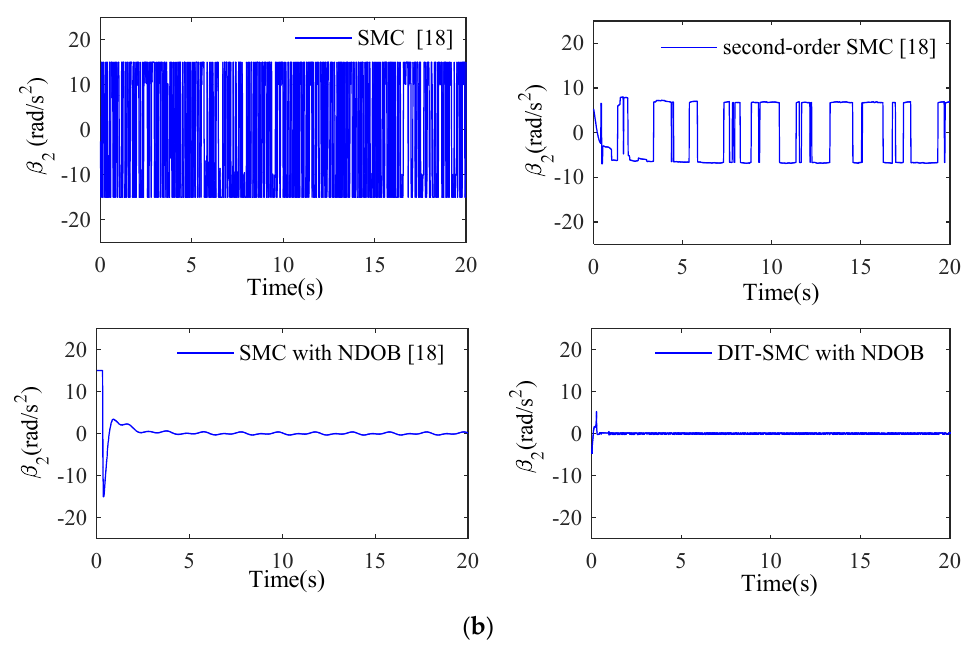
Figure 5. The acceleration and angular acceleration of follower robot 2; (a) α 2 ; (b) β 2 .